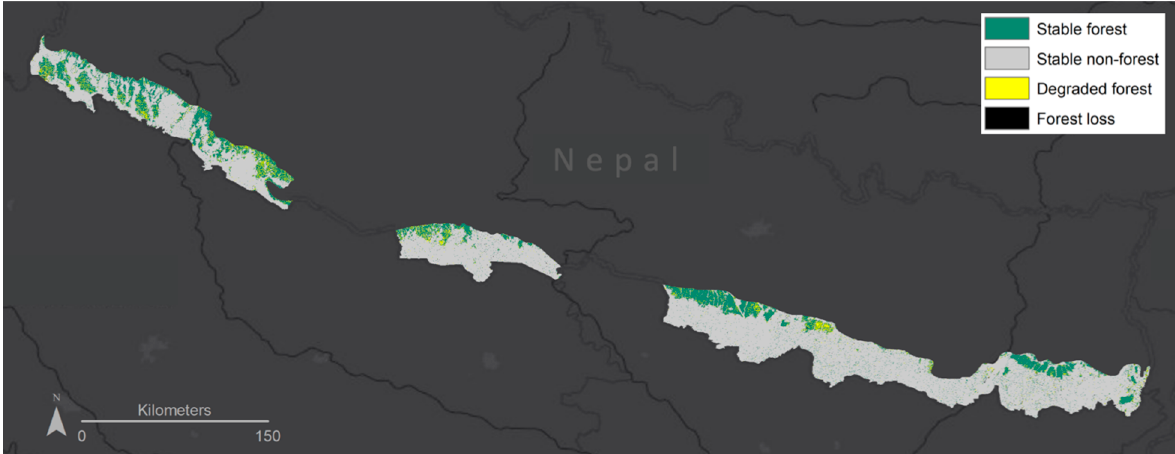
Figure 3. Final CODED output map for all of Terai showing areas of degradation and deforestation occurring between 2010 and 2020 relevant to greenhouse gas emissions estimates, along with areas of stable forest and nonforest. Table 2. Error matrix with sample counts for the Map 11 iteration. Each grid cell is the correspondence between the final map (rows) and the reference data (columns). Note that the row (map values) totals do not correspond to the 250 samples originally derived from each class because the map is different from the stratification used to create the sample (see Section 2.4).